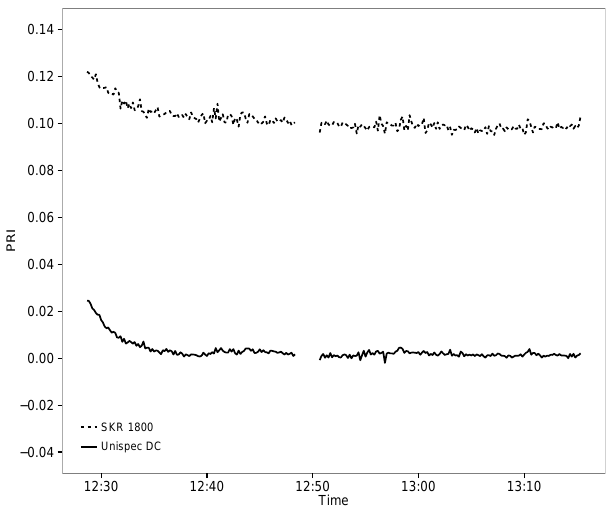
Figure 2. Photochemical reflectance index (PRI) response to a dark- to-light transition for alfalfa ( Medicago sativa ), as recorded by a UniSpec DC instrument and the SKR 1800 sensor